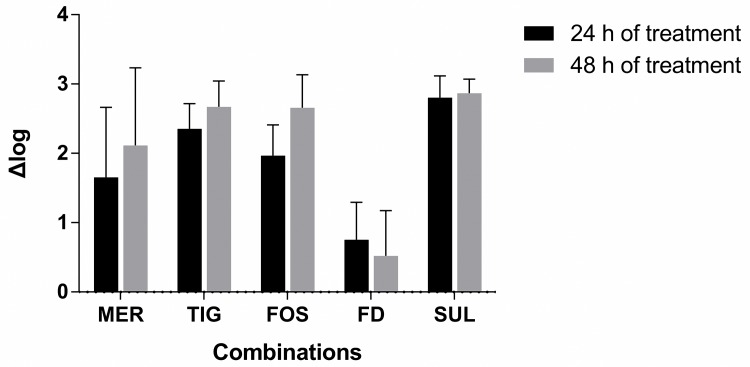
Comparison of the efficacies of colistin-rifampin combination vs other combinations after 24 and 48 h of treatment.CST, colistin; MER, meropenem; TIG, tigecycline; FOS, fosfomycin; FD, fusidic acid; RIF, rifampin; SUL, sulbactam. Δlog means the log10 recovered CFU of other combinations minus the log10 recovered CFU of colistin-rifampin combination.